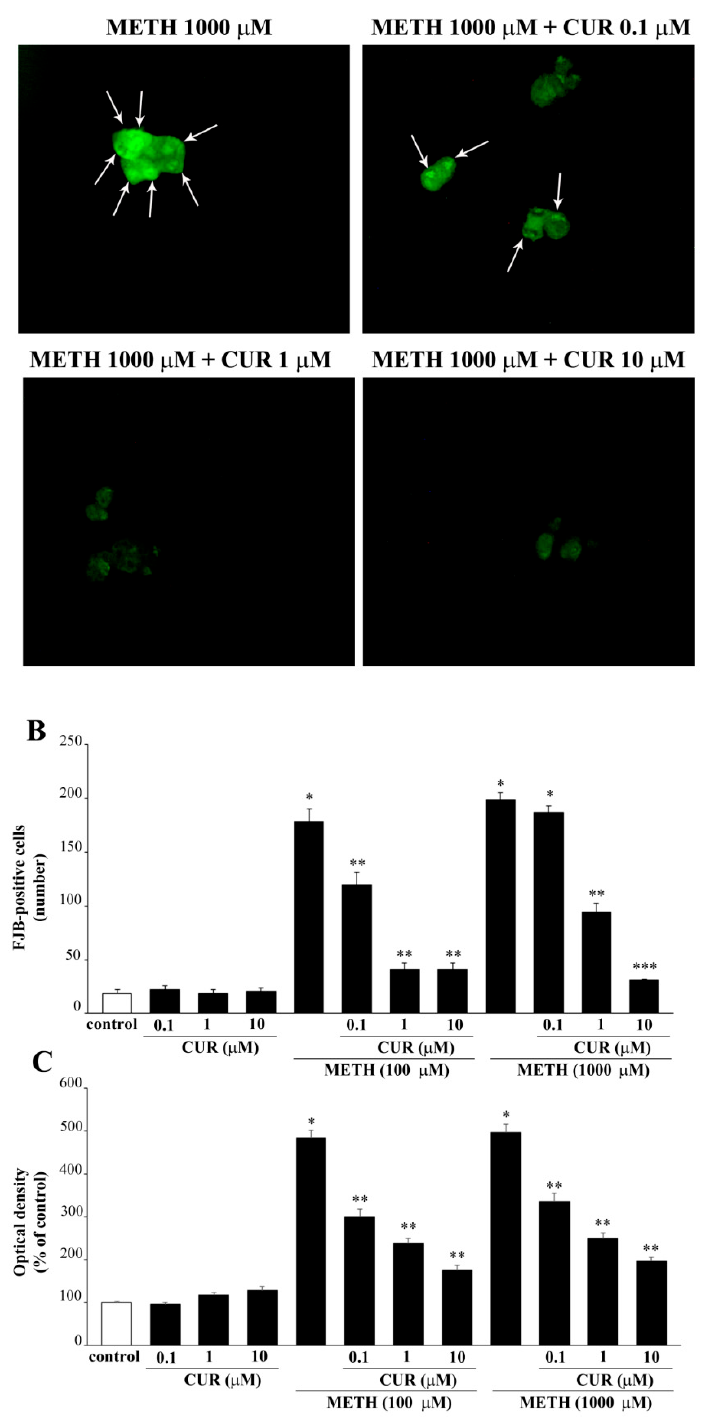
Figure 11. CUR decreases METH-induced FJB-responsiveness in PC12 cells. ( A ) Representative pictures of FJB-stained PC12 cells after various treatments The graphs ( B , C ) report the number and the intensity of FJB fluorescent cells, respectively. Arrows indicate FJB intensely positive cells. * p ≤ 0.05 compared with control; ** p ≤ 0.05 compared with METH 100 µ M; *** p ≤ 0.05 compared with METH 1000 μ M + CUR 1 μ M. Scale bar = 17.3 μ M.